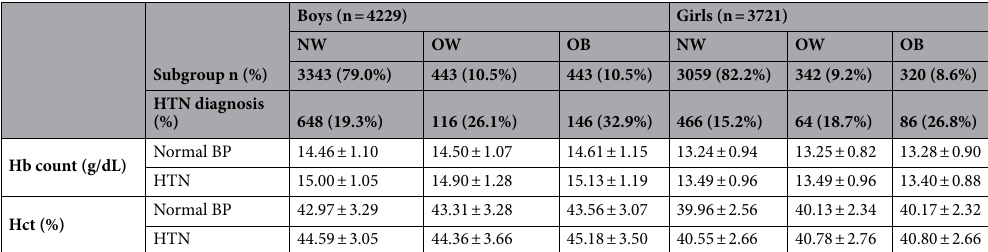
Table 2. Hemoglobin count and hematocrit according to sex, body mass index, and hypertension status. Data are presented as mean ± standard deviation. NW normal weight; OW overweight; OB obese; HTN hypertension; Hb hemoglobin; Hct hematocrit; BP blood pressure. HTN was defined as (i) systolic blood pressure (SBP) or diastolic blood pressure (DBP) ≥ the 95th percentile considering age, sex, and height or (ii) SBP ≥ 130 mm Hg or DBP ≥ 80 mm